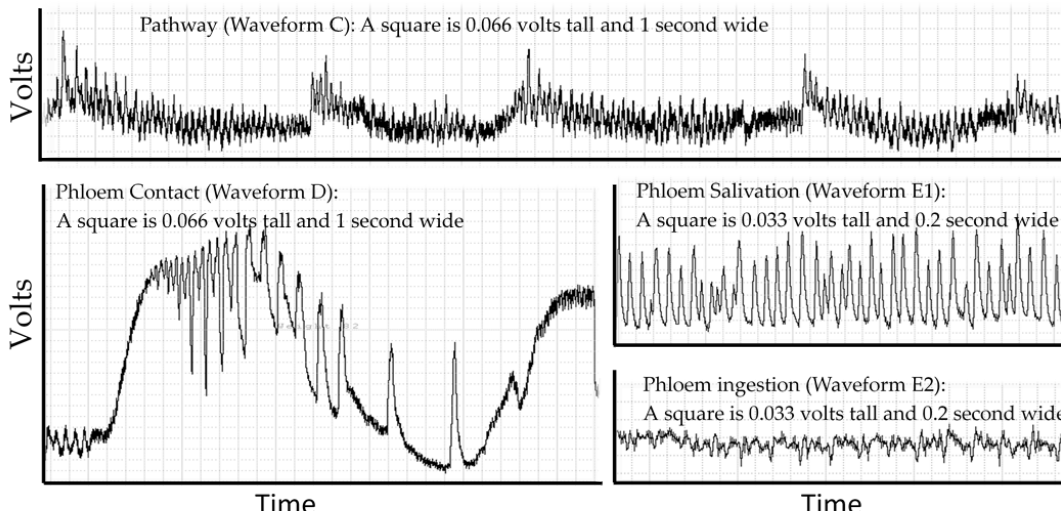
Figure 1. The repetitive patterns for four waveforms in the D. citri . Pathway waveform (C), where stylets are moving through leaf cuticle. Phloem contact (waveform D) has large changes in voltage, creating a stereotypical set of large spikes that gradually diminish in frequency and can then transition into phloem salivation (waveform E1). E1 can transition into phloem ingestion (waveform E2). The displayed waveforms occurred in a span of 200 seconds within a probe that lasted 4 h.